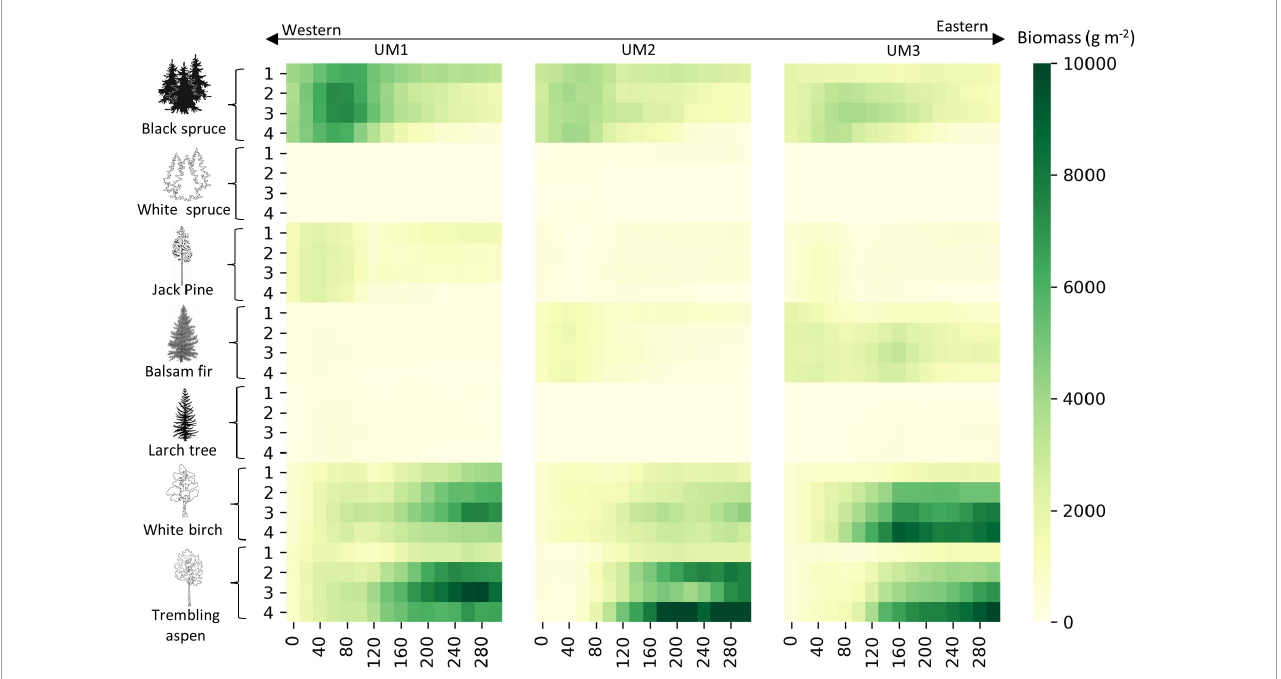
FIGURE7 Mean simulated annual biomass (wood + roots) (tC ha - 1 ) per species projection for 300 years (2010–2310) under four climate scenarios (1, baseline; 2, RCP2.6; 3, RCP4.5; 4, RCP8.5).